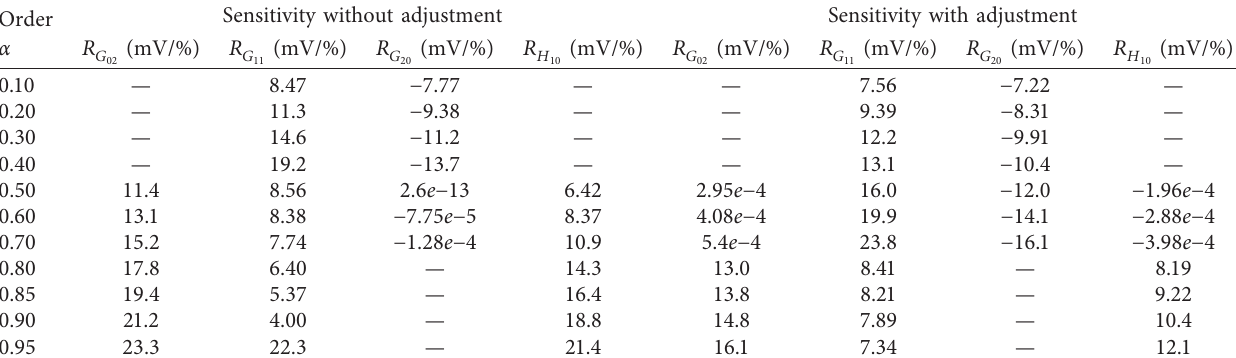
Table 3: Sensitivity analysis.